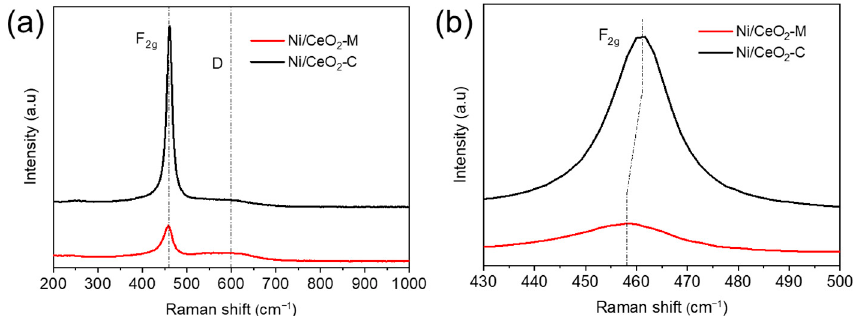
Figure 3. ( a ) Raman profile and ( b ) enlarged profile of reduced Ni/CeO 2 -C and reduced Ni/CeO 2 -M catalysts.